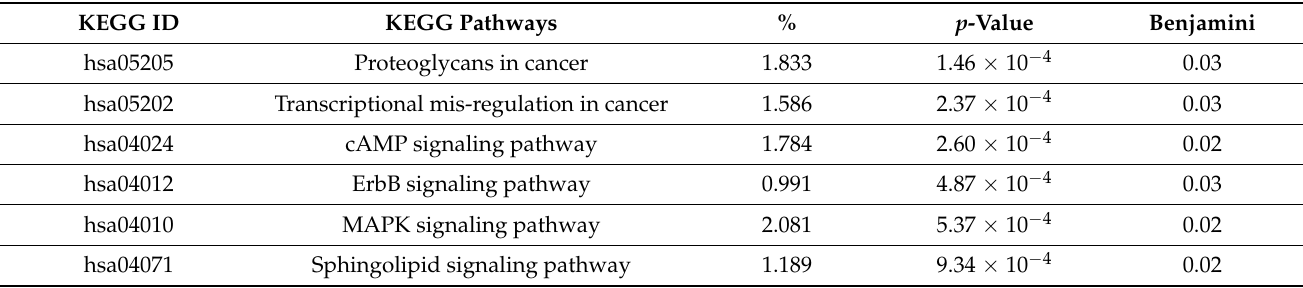
Table 2. List of KEGG pathways involved in 2073 unique gene target predictions found in 8 miRNAs in 1675 cells exposed to IH compared